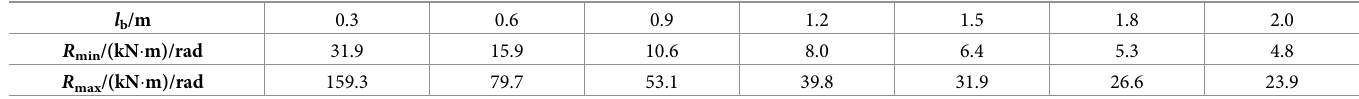
Table 7. Regional boundary of initial bending stiffness of semi-rigid joint under the negative